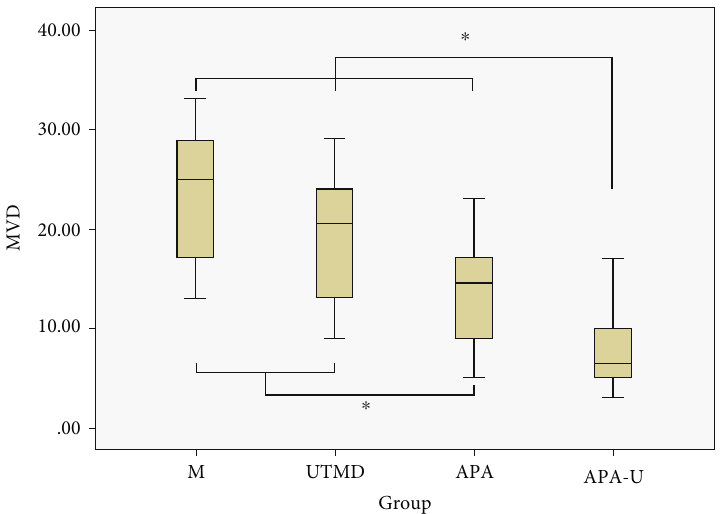
Figure 7: MVD in the tumor tissues after di ff erent treatments. Note: asterisks indicate the pairs having statistically signi fi cant di ff erences in the ANOVA test followed by LSD t